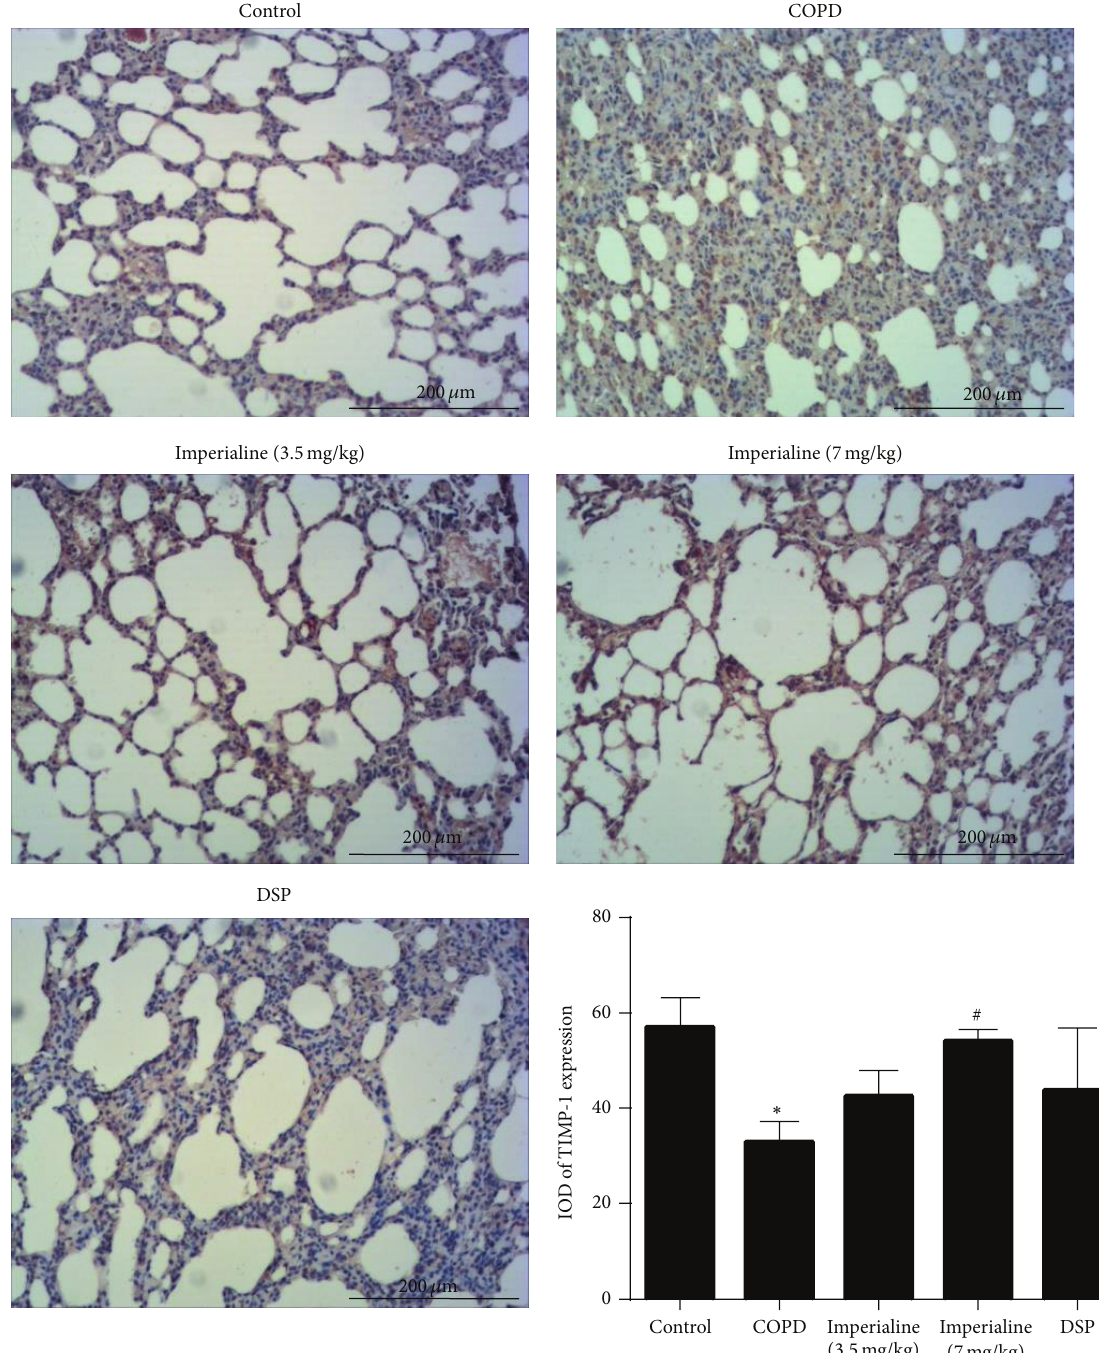
Figure 12: Immunohistochemical staining of TIMP-1 in lung tissues of rats in different groups and IOD of TIMP-1 expression. Results were expressed as the mean ± SEM ( 𝑛 = 10 ). Significant difference compared with the control group was designated as ∗ 𝑃 < 0.05 . Significant difference compared with the COPD group was designated as # 𝑃 < 0.05